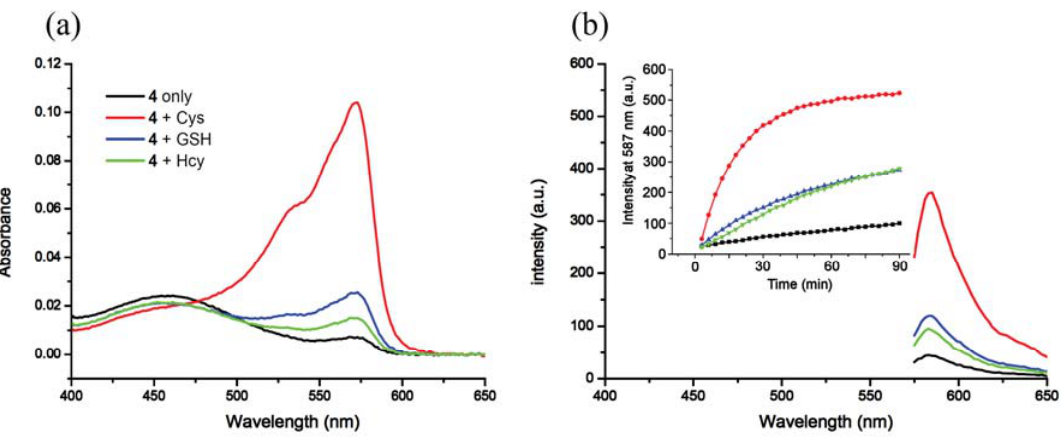
Figure 1. Spectral response of 4 towards various thiols. ( a ) Absorption spectra of 4 (2.5 µM) upon addition of thiols (2 equiv) in phosphate buffer (pH 7.4, 50 mM) at 20 min; ( b ) Fluorescence spectra of 4 (2.5 µM) upon addition of thiols (2 equiv) in phosphate = 565 nm) at 20 min. The inset shows time-dependent buffer (pH 7.4, 50 mM) ( λ ex fluorescence changes ( λ = 587 nm). The legends in ( a ) correspond to ( b ) as em